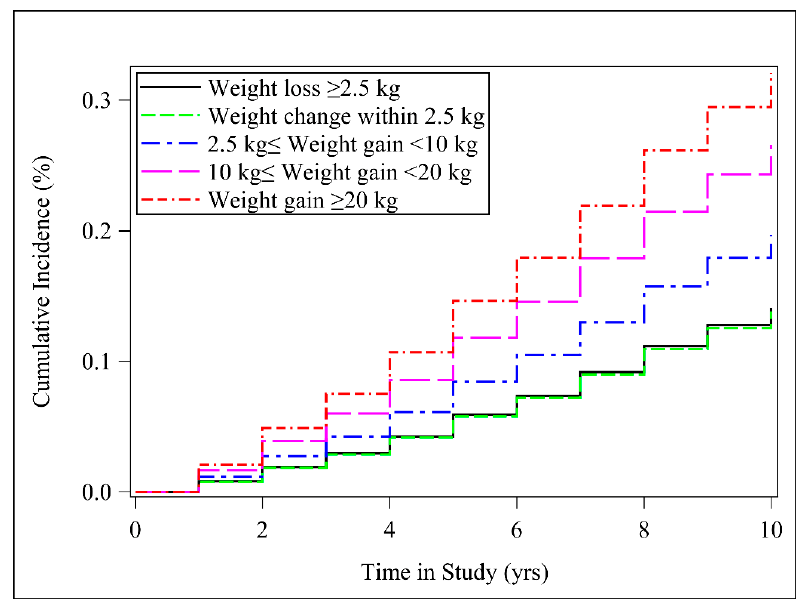
Figure 2. Cumulative incidence curve for hypertension by the absolute weight change category. Multivariable Cox regression model adjusted for sex, baseline age, race/ethnicity, family income, education, smoking status, and BMI at 25 years.